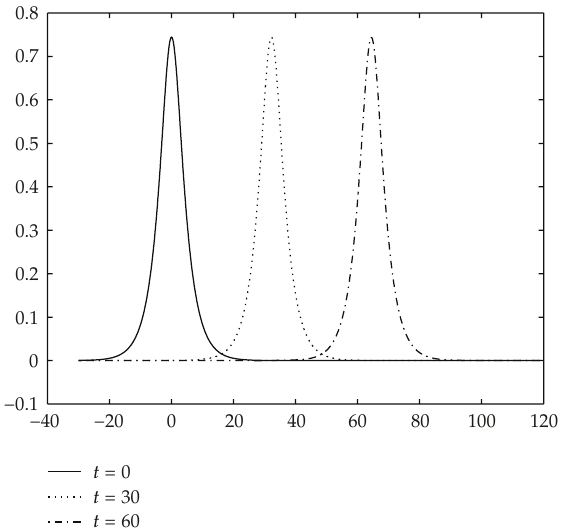
Figure 3: Exact solutions of u (cid:5) x,t (cid:6) at t (cid:7) 0 and numerical solutions computed by scheme (cid:5) 2.3 (cid:6) – (cid:5) 2.5 (cid:6) at t (cid:7) 30 , 60 for p (cid:7)